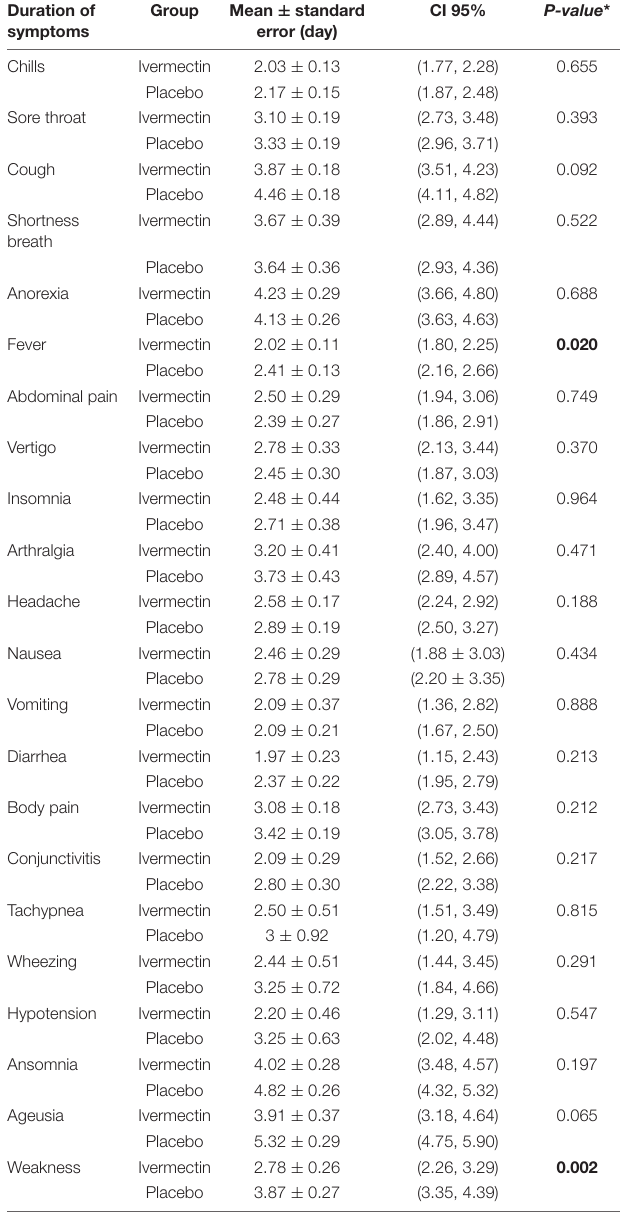
TABLE 7 | Mean duration of symptoms in outpatients. Duration of